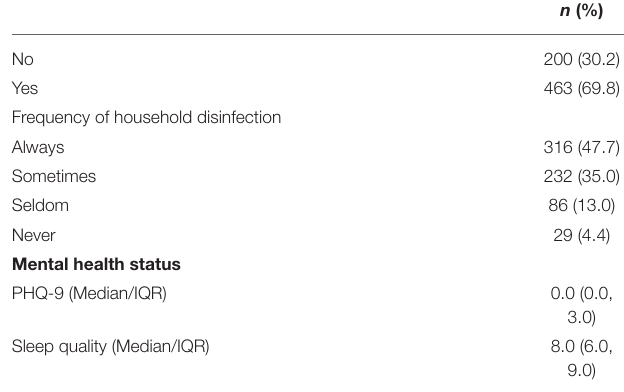
TABLE 1 | Baseline characteristics of factory workers ( n =